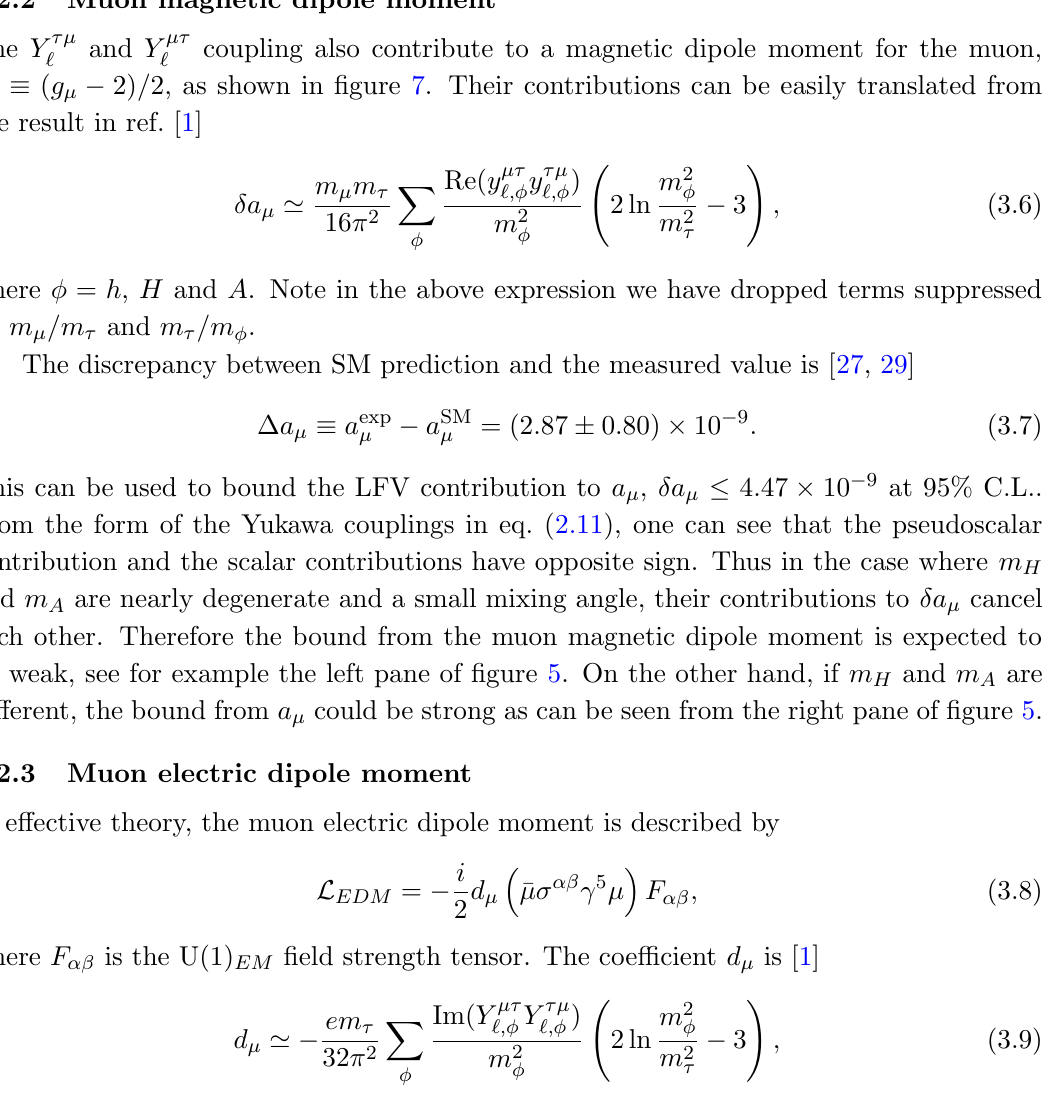
and Y (cid:22)(cid:28) contribution to the muon magnetic dipole ‘ ‘